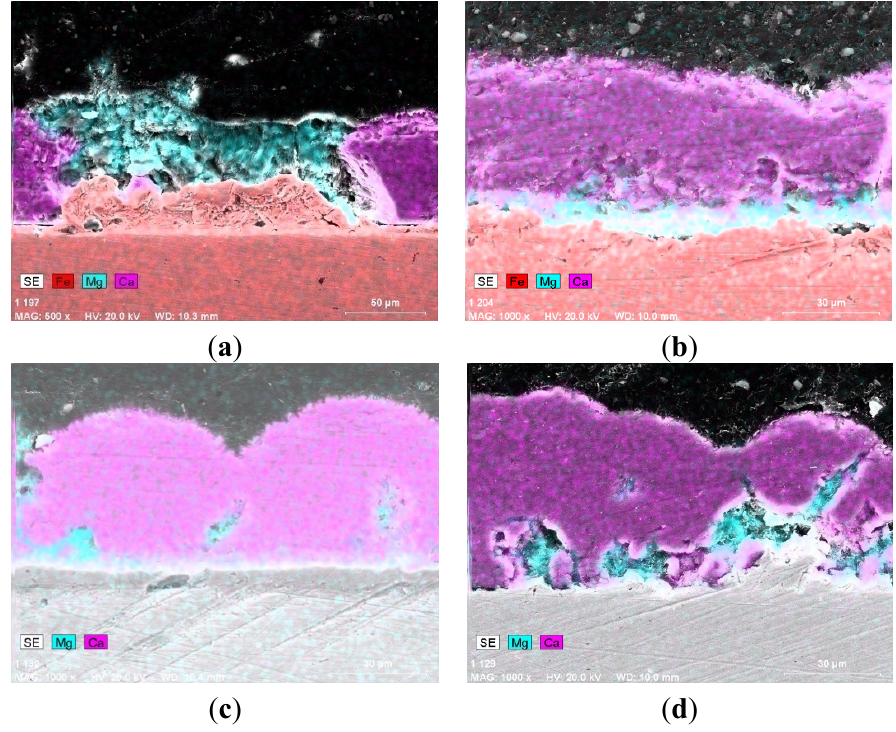
Figure 2. Secondary electron micrographs and corresponding overlaid Energy Dispersive X-Ray Analysis (EDX) element distribution maps for Fe, Mg and Ca of cross-section of calcareous deposit formed after 144 h immersion in seawater at applied current densities